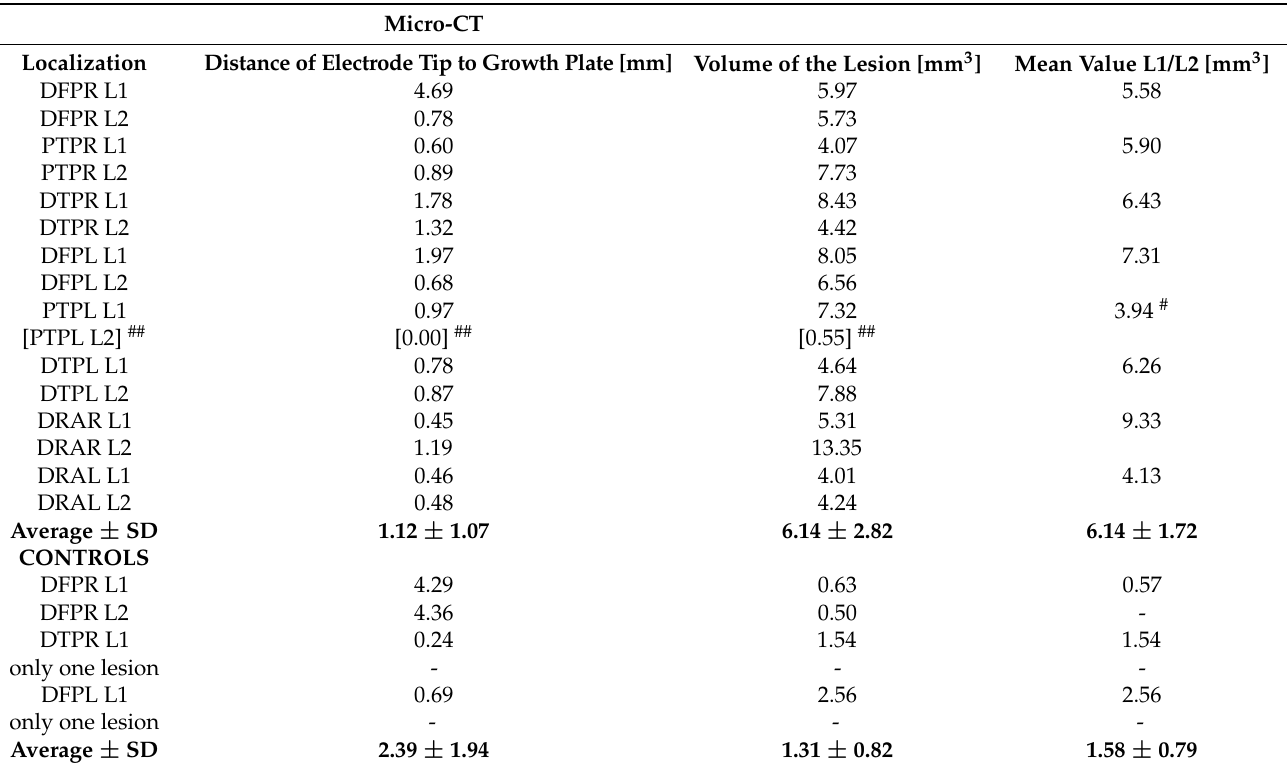
Table 1. Results of targeting, distance measurements, and volume determination.